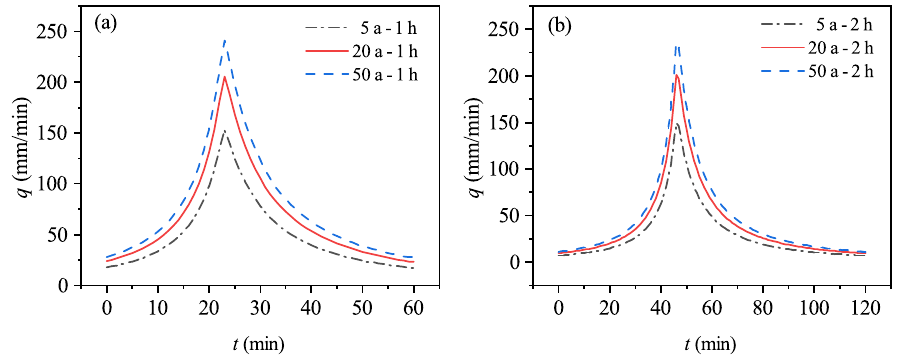
Figure 3. Rainfall processes with different rainfall return periods and different rainfall durations: ( a ) Rainfall duration of 1 h rainfall process. ( b ) Rainfall duration of 2 h rainfall